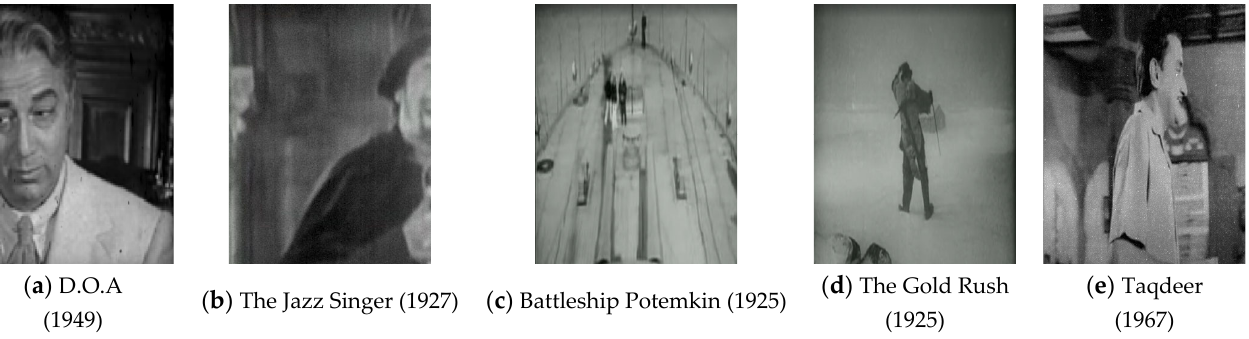
Figure 6. Examples of old noisy video frames collected from old movies from the 1920s–1970s, which illustrates the presence of artifacts and noise pattern in old video frames. illustrates the presence of artifacts and noise pattern in old video